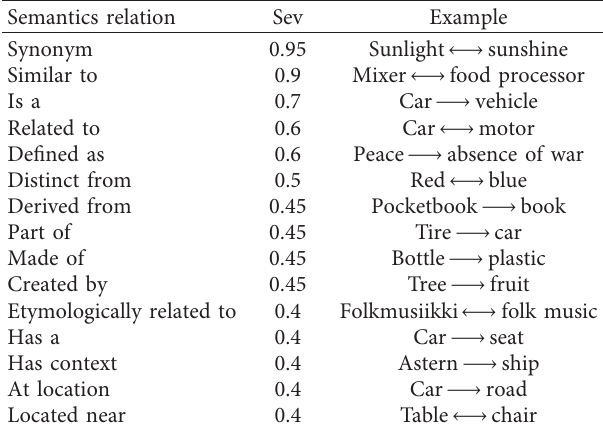
Table 3: The selected semantic